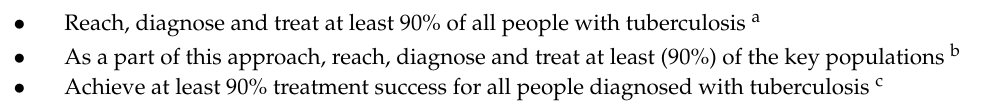
Table 1. The 90-(90)-90 targets for Global Tuberculosis